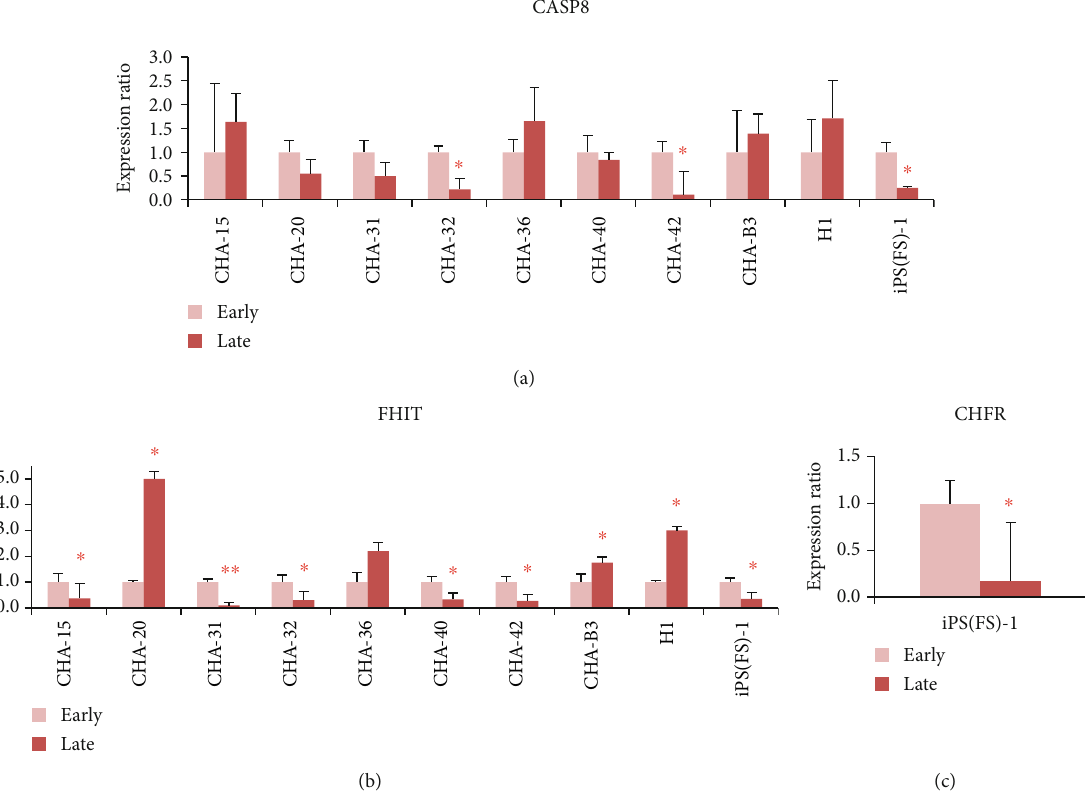
Figure 4: Expression level of the three genes between early passage and late passage of 10 cell lines using real-time PCR analysis. Expression ratio of the CASP8 gene (a), FHIT gene (b), and CHFR gene in iPS (FS)-1 cell in CHA-20 (1.00: 5.21, p = 0 : 030 ) and H1 (1.00: 3.00, p = 0 : 20 ) (Figure 4(b)). The expression level of the CHFR gene signi fi cantly decreased at late passage in iPS (FS)-1 cell lines (1.00: 0.17, p = 0 : 020 ) (Figure 4(c)).